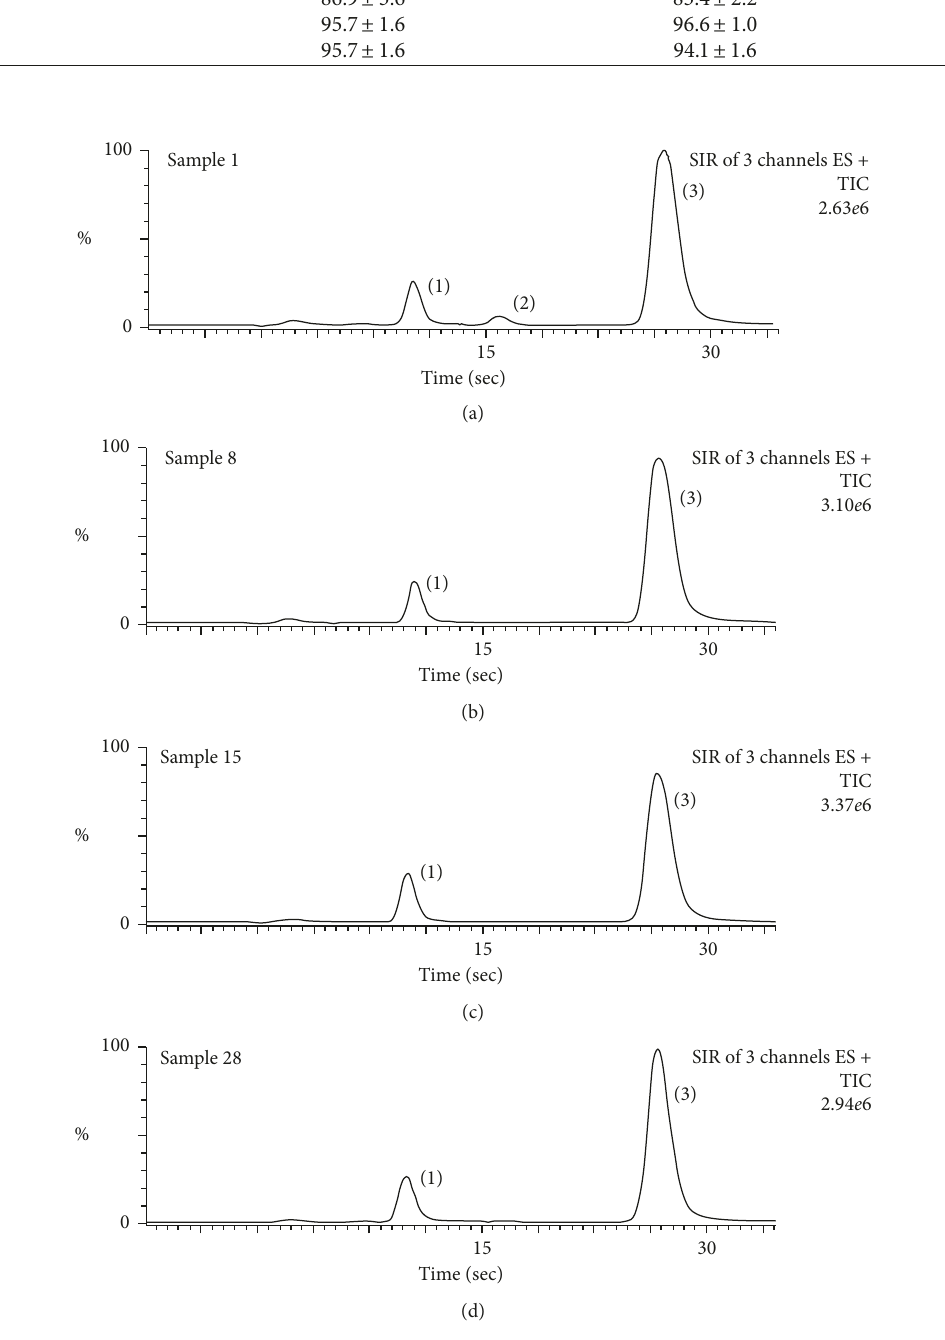
Figure 2: Representative UHPLC-MS chromatograms for some of the studied tea samples: (1) theobromine, (2) theophylline, and (3)